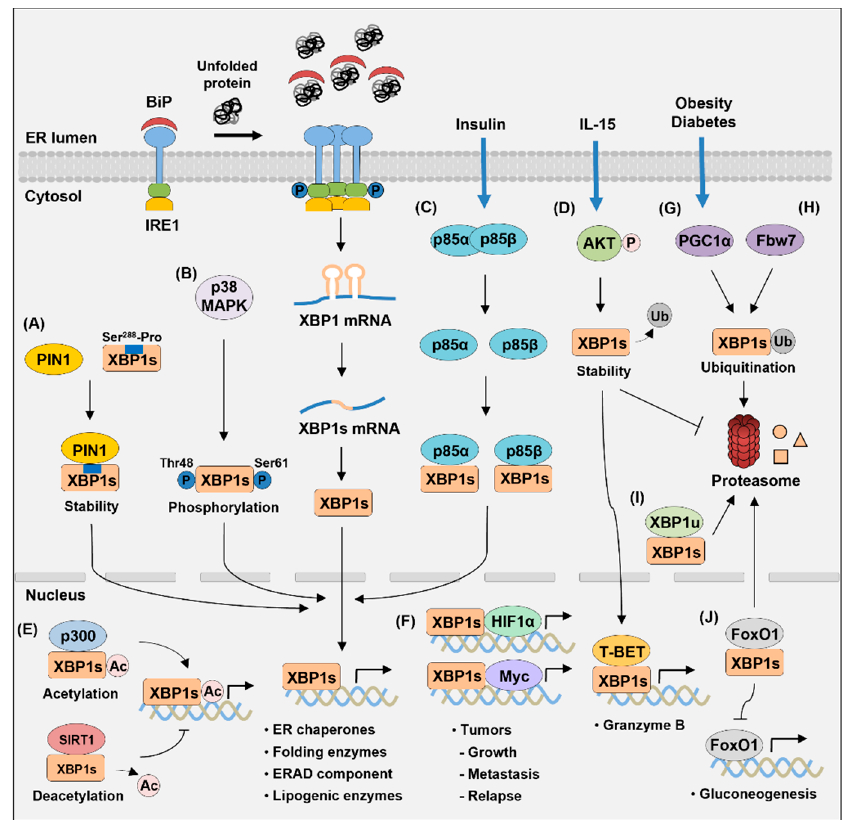
Figure 4. Proteins interacting with XBP1s. XBP1s interacts with a variety of other proteins, and these molecular mechanisms are important for regulating the protein stability and transcriptional activity of XBP1s. ( A ) XBP1s interacts with PIN1 in a phosphorylation-dependent manner, and this interaction increases the stability of XBP1s. XBP1s interacts with the WW domain of PIN1 via the Ser288-Pro motif of XBP1s. ( B ) The p38 MAPK directly phosphorylates the Thr48 and Ser61 residues of XBP1s, thereby enhancing the nuclear translocation of XBP1s [134]. ( C ) Insulin induces the interaction of XBP1s with p85 α and p85 β , the regulatory subunits of PI3K, leading to increased nuclear translocation of XBP1s. ( D ) IL-15 induces the phosphorylation of AKT, which increases the stability of XBP1s by inhibiting ubiquitination. XBP1s interacts with T-BET to bind to the proximal region of the granzyme B promoter. ( E ) XBP1s is regulated at the post-translational level via acetylation and deacetylation, mediated by its interaction with p300 and SIRT1, respectively. ( F ) XBP1s forms a transcriptional complex with HIF1 α , which increases the tumorigenicity and progression of triple-negative breast cancer (TNBC). XBP1s also forms a complex with MYC, enhancing the transcriptional activity of XBP1s in tumors. ( G ) PGC1 α reduces the XBP1s stability, which negatively affects the activity and protein level of XBP1s. PGC1 α and XBP1s interact with each other in their activation domains to promote the protein degradation of XBP1s via ubiquitination. ( H ) Fbw7 interacts with XBP1s in a phosphorylation-dependent manner to promote the ubiquitination and degradation of XBP1s. ( I ) XBP1u functions as a negative feedback regulator of XBP1s via direct interaction. The complex of XBP1u and XBP1s is rapidly degraded by the proteasomes due to the degradation domain contained in XBP1u. ( J ) XBP1s binds directly to the FoxO1 and facilitates the degradation of FoxO1 via the 26S proteasome pathway. FoxO1 is a transcription factor that regulates gluconeogenesis by increasing the expression of phosphoenolpyruvate carboxykinase and glucose 6 phosphatase. The transcriptional activity of XBP1s is regulated at the post-translational level via acetylation and deacetylation, mediated by its interaction with p300 and SIRT1, respec- tively [165]. p300 is a histone acetyltransferase, and SIRT1 is a class III histone deacetylase. They both regulate the acetylation/deacetylation of non-histone proteins, including degradation of XBP1s via ubiquitination. XBP1s also interacts with p85 α and p85 β , the